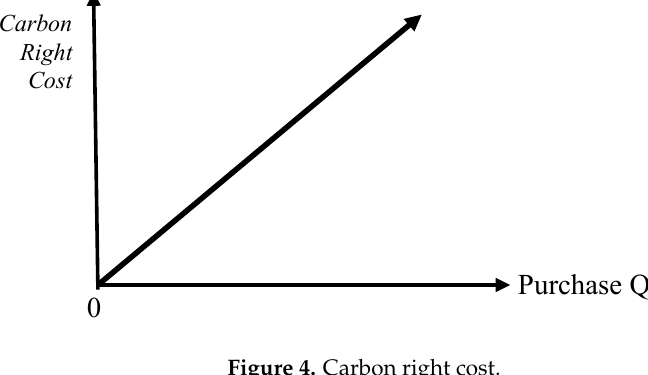
Figure 4. Carbon right cost.